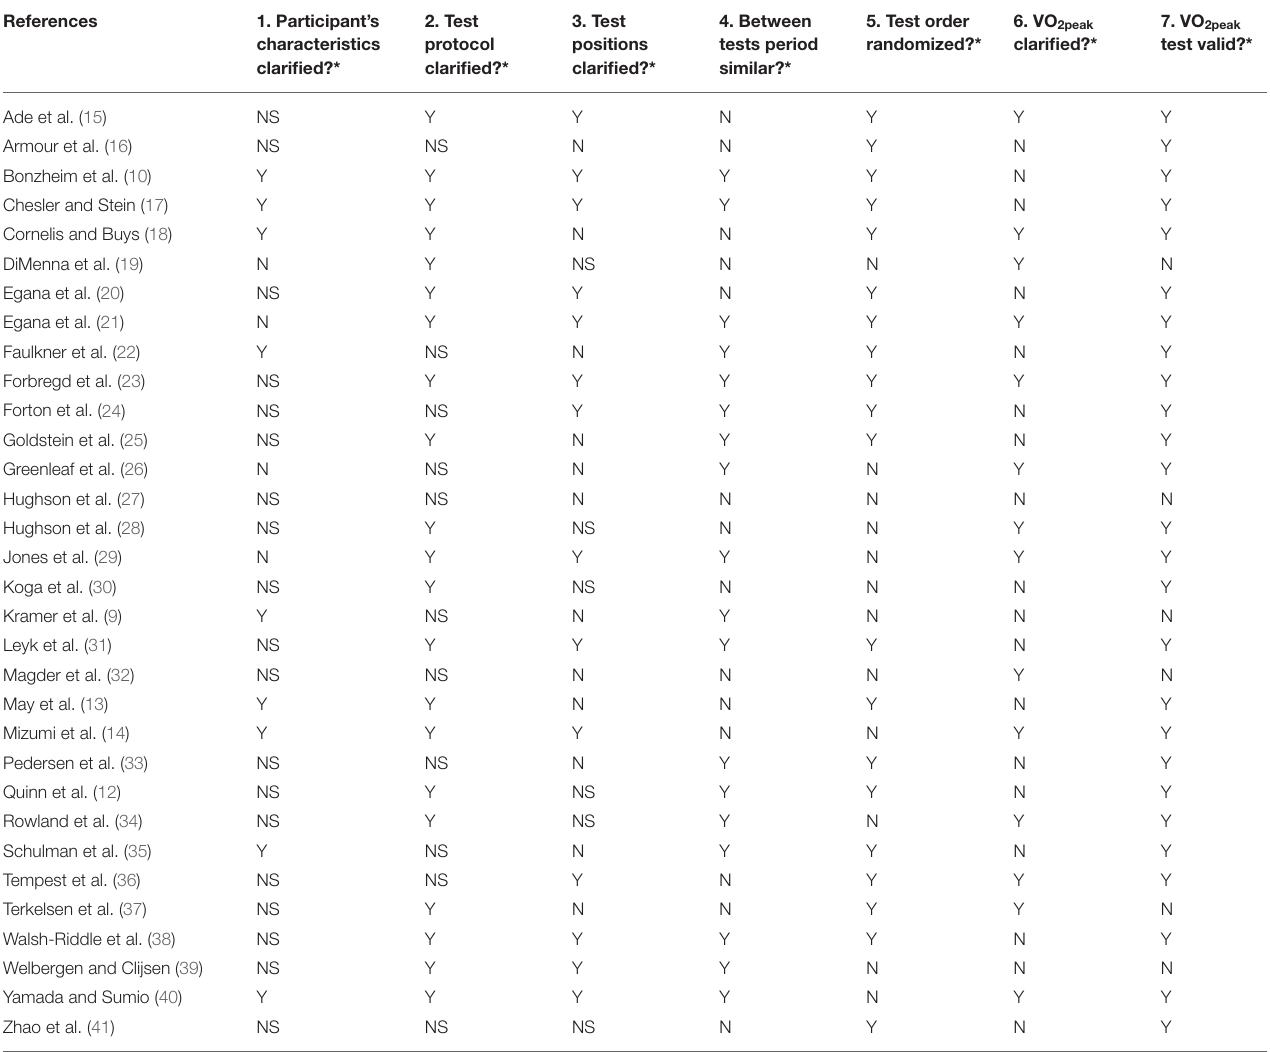
TABLE 1 | Methodological quality evaluation for included studies ( n =